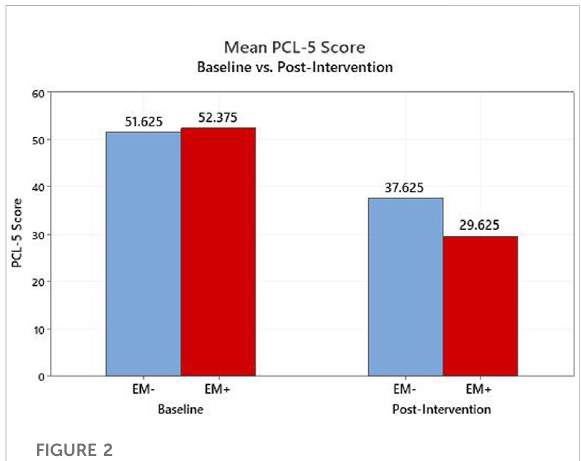
FIGURE 2 PCL-5 Scores from baseline to post-intervention for completers; Breakdown by eye movement group (EM+, EM −